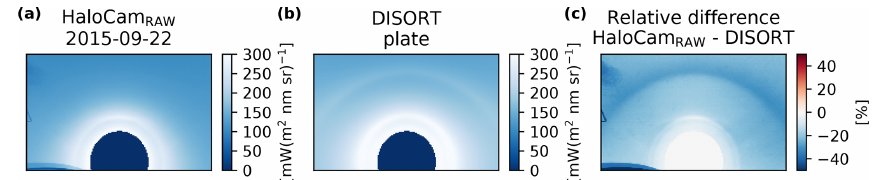
Figure 8. (a) HaloCam RAW R-channel radiance averaged over all 22 ◦ halo images for 22 September 2015. (b) DISORT simulations for the best-matching ice crystal and cirrus properties in the 22 ◦ halo region, without taking into account information about the 46 ◦ halo region. (c) Relative difference between HaloCam RAW -averaged radiances and the simulated DISORT